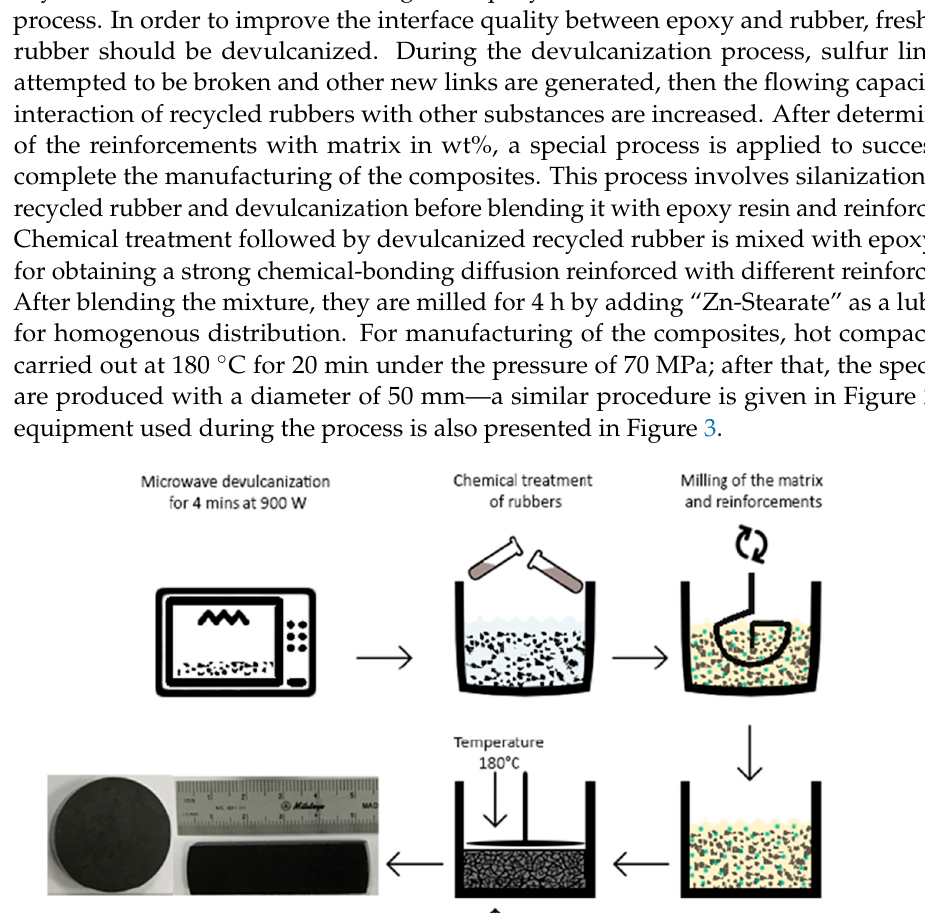
Figure 1. Depiction of the LIBS system used in this study.